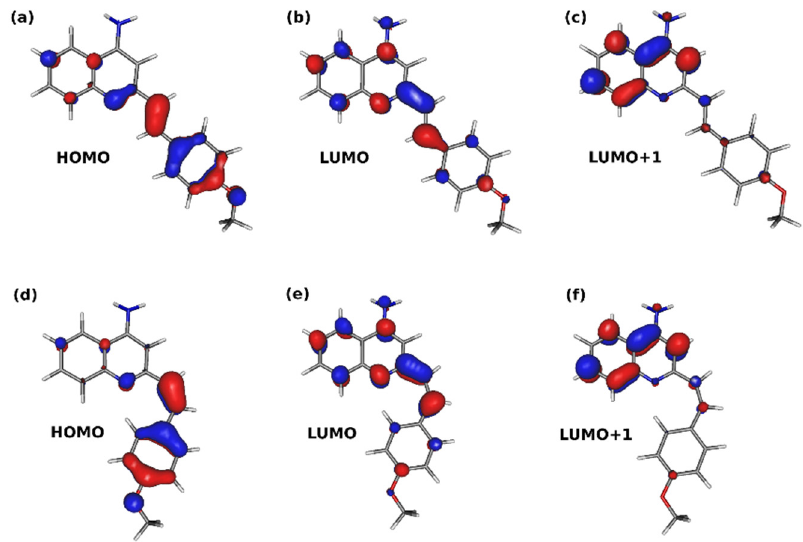
Figure 8. Frontier molecular orbitals of E and Z isomers of A1: ( a ) A1-E HOMO, ( b ) A1-E LUMO, ( c ) A1-E LUMO+1, ( d ) A1-Z HOMO, ( e ) A1-Z LUMO, ( f ) A1-Z LUMO+1.